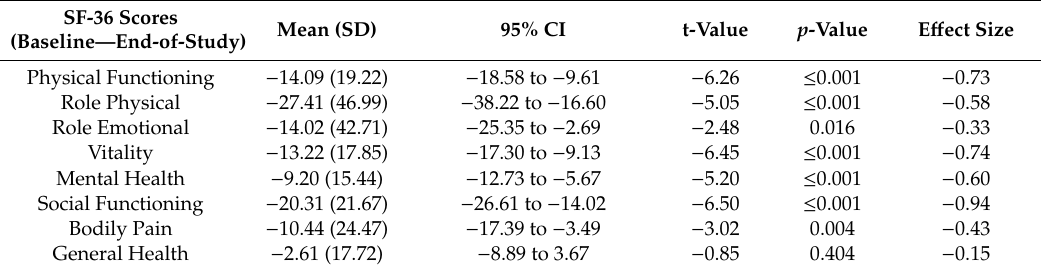
Table 2. Output paired sample t-test analyzing the di ff erence in Short Form-36 (SF-36) scores between baseline and end-of-study.